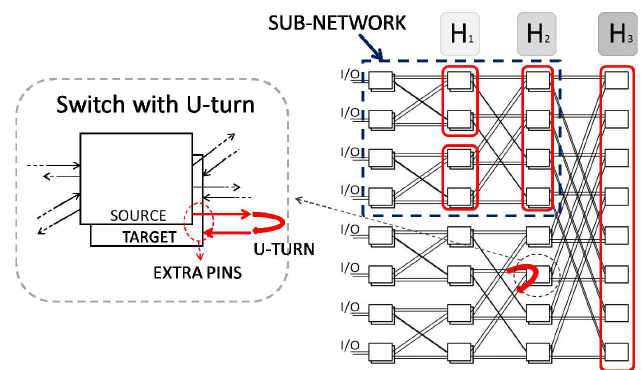
Figure 4. Folded bypassed MSSN enhanced with U-turn bypasses.